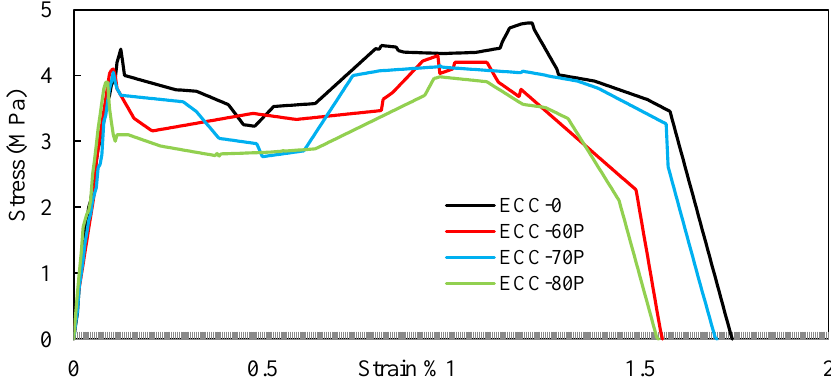
Figure 4. Stress – strain curves obtained from the direct tensile strength tests. Figure 4. Stress–strain curves obtained from the direct tensile strength tests.